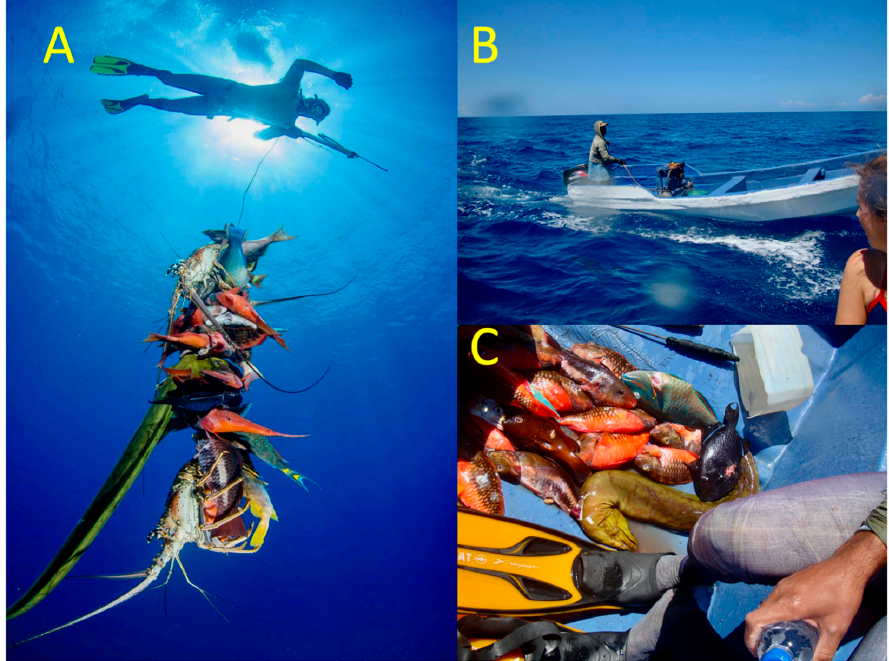
Figure 8. ( A ) Observed spearfishing in the Montecristi Region March 2015. ( B ) Fisher with a hookah rig for supplying air to divers. ( C ) An afternoon’s catch of mostly parrotfish. Photographs by Jose Alejandro Alvarez.